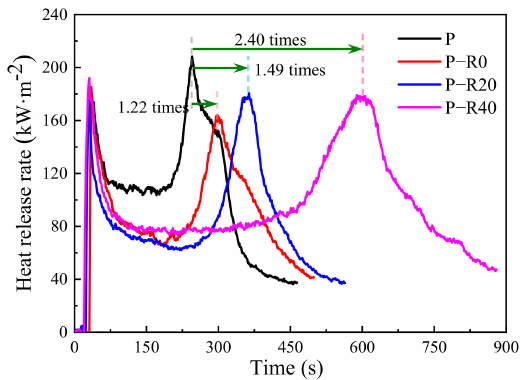
Figure 9. HRR of control and modified wood specimens.